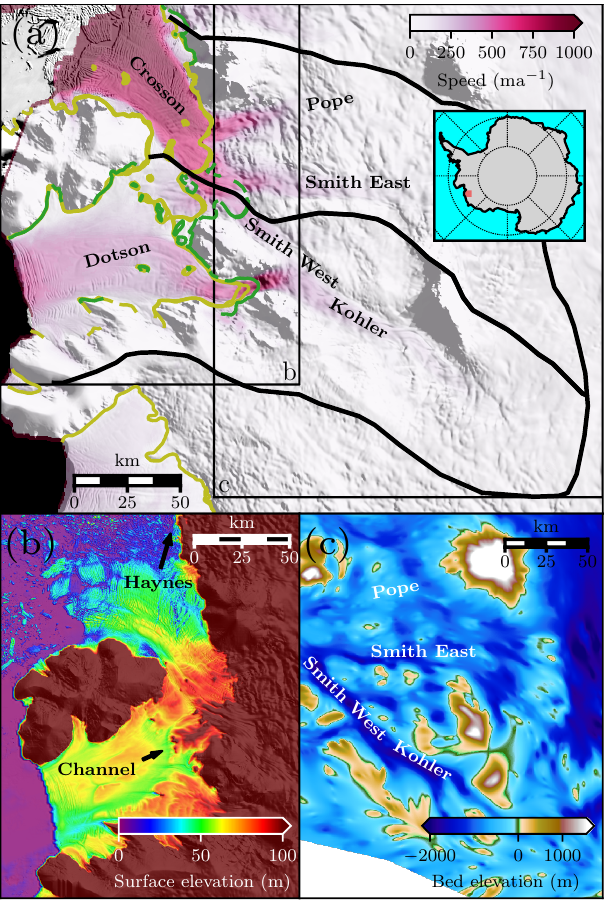
Figure 1. Overview of study area: (a) 1996 surface speed overlaid on the mosaic of Antarctica (MOA) (Haran et al., 2013). Yellow and green lines show grounding-line positions in 1996 and 2011, respec- tively (Rignot et al., 2014). Black lines indicate catchment bound- aries of Crosson and Dotson used for flux calculations. (b) Surface elevation relative to the EGM2008 geoid from WorldView/GeoEye stereo DEM mosaic (Shean et al., 2016). (c) Ice-bottom elevation relative to the EGM2008 geoid, which represents bed elevation over grounded